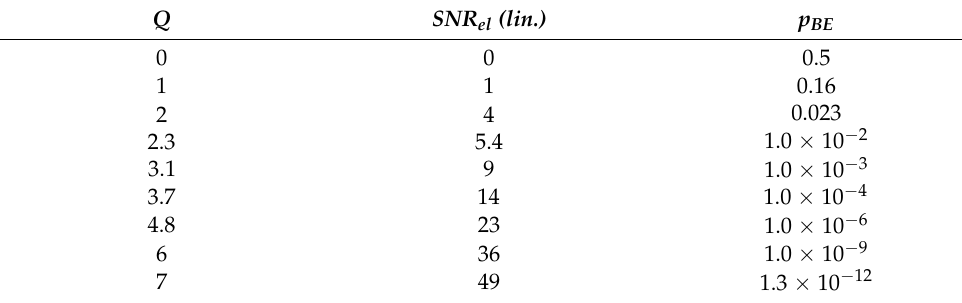
Table A2. Relations between Q and BER in OOK